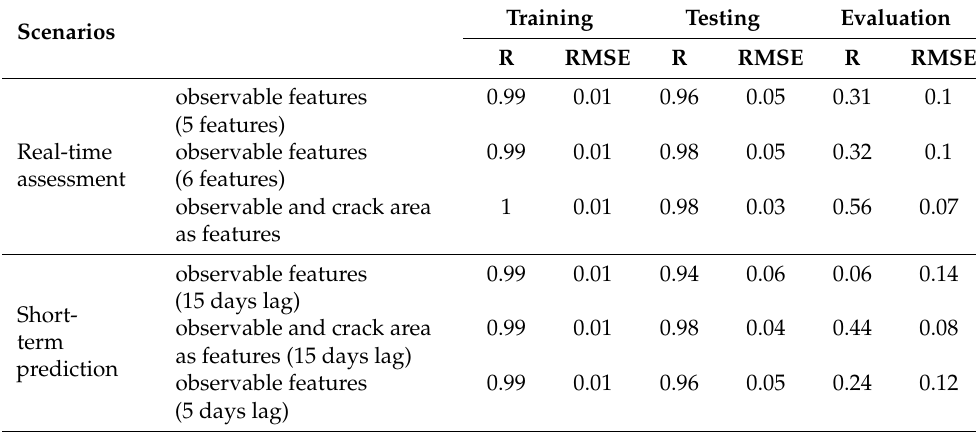
Table 6. Summary of RF models performance on all data